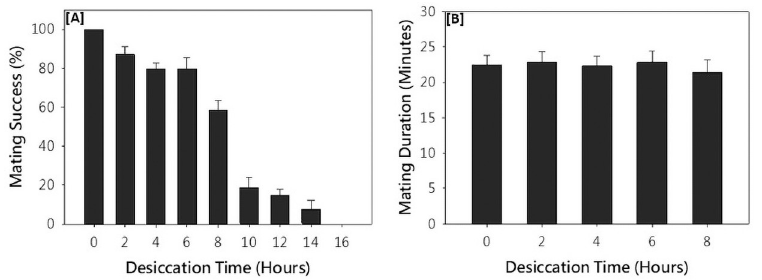
Fig 1. Mating success and mating duration of D . melanogaster adults under varying desiccation treatments. A. Desiccation Treatment and Mating Success. Bar graph representing the effect of desiccation time on the mating success of outcrossed D . melanogaster flies. Each bar represents the average value recorded for a total of 54 pairs (9 pairs per replicate) and the error bars depict values of standard error. P-value obtained from ANOVA: Single Factor test: 1.4 � 10 − 20 . B. Desiccation Time and Mating Duration. Bar graph illustrating the effect of desiccation on the mating duration (i.e. copulation duration) of outcrossed D . melanogaster flies. Each bar is the average value recorded for 54 pairs, the bars delineating standard error. P-value obtained from ANOVA: Single Factor test: 0.69034.